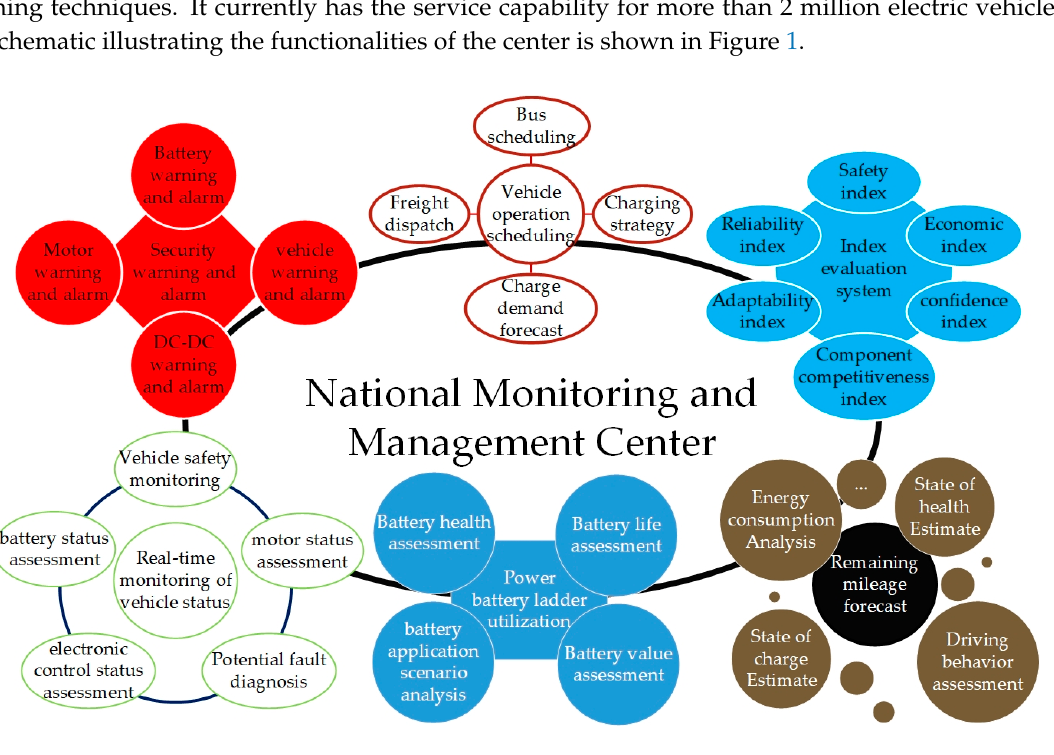
Figure 1. NMMCNEV’s role in the management of electric vehicles.